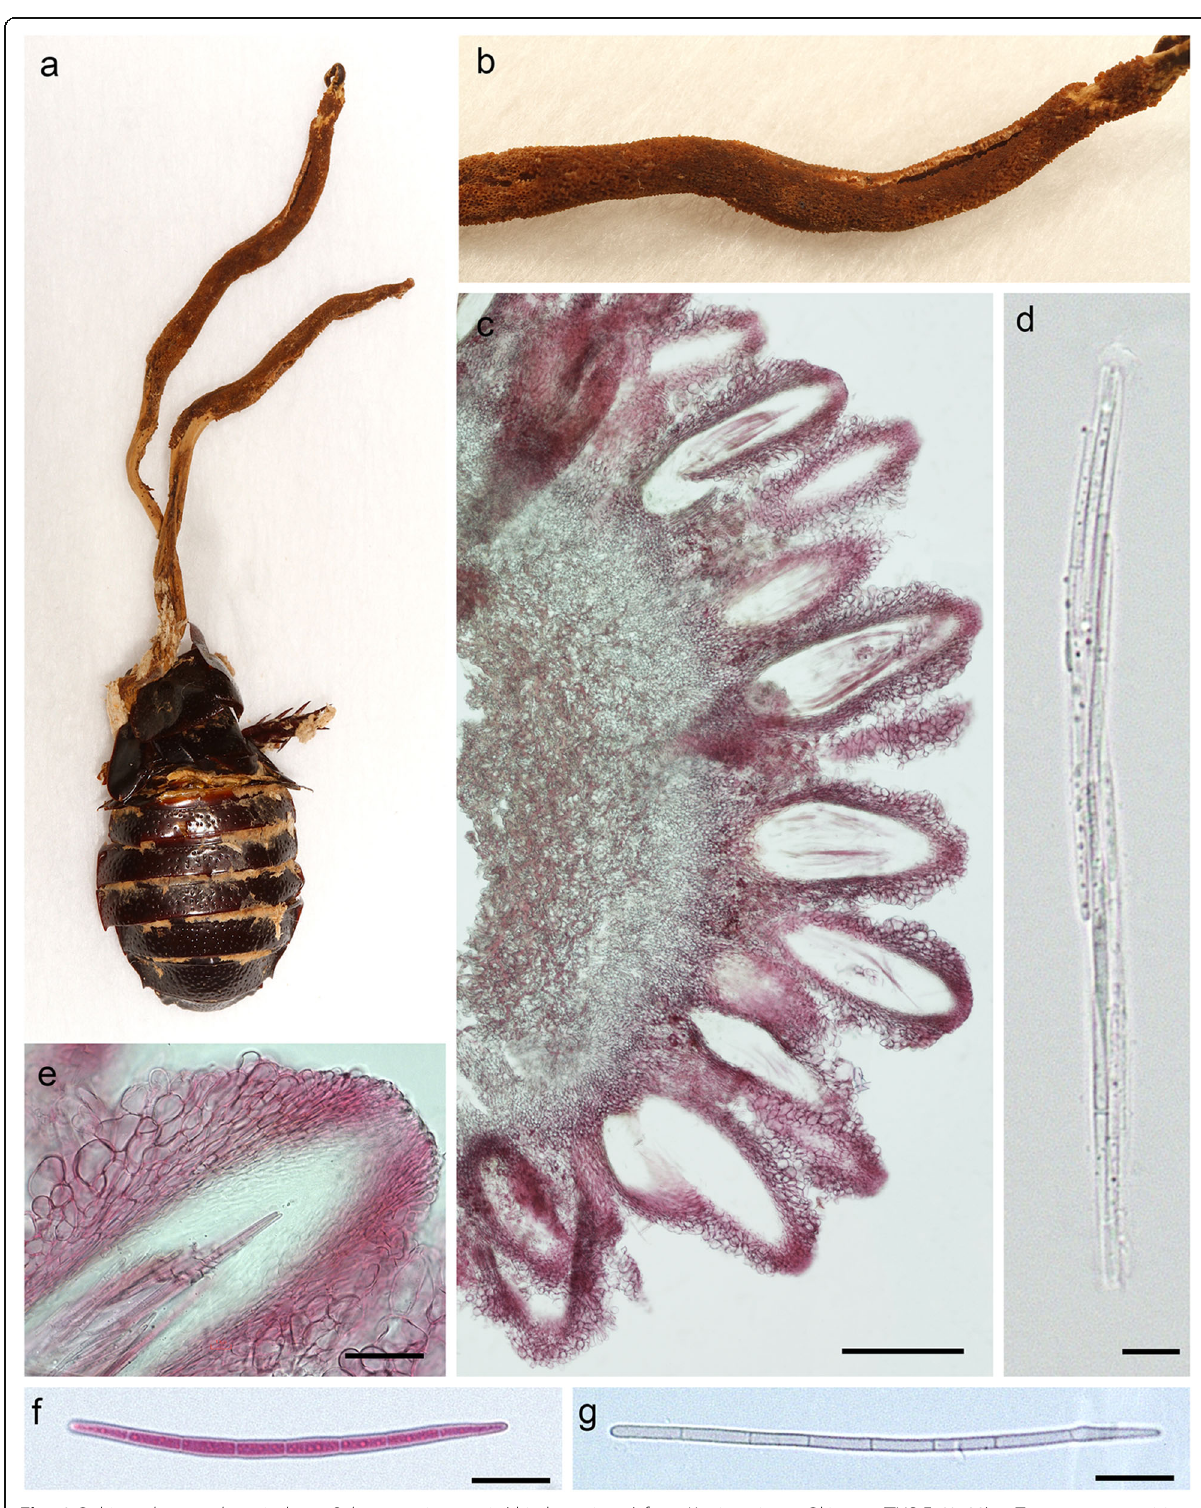
Fig. 6 Ophiocordyceps salganeicola on Salganea taiwanensis (dried specimen) from Kunigami-son, Okinawa (TNS-F-60532). a Two ascomata arising from S. taiwanensis . b Close-up of dried ascoma. c Cross section of ascoma showing the perithecial arrangement. d Ascus with spirally twisted ascospores. e Perithecial ostiole. f and g 8-celled ascospore. Scale bars = c 200 μ m, d 15 μ m, e 10 μ m, f and g 20 μ m. Presented as JPMA124